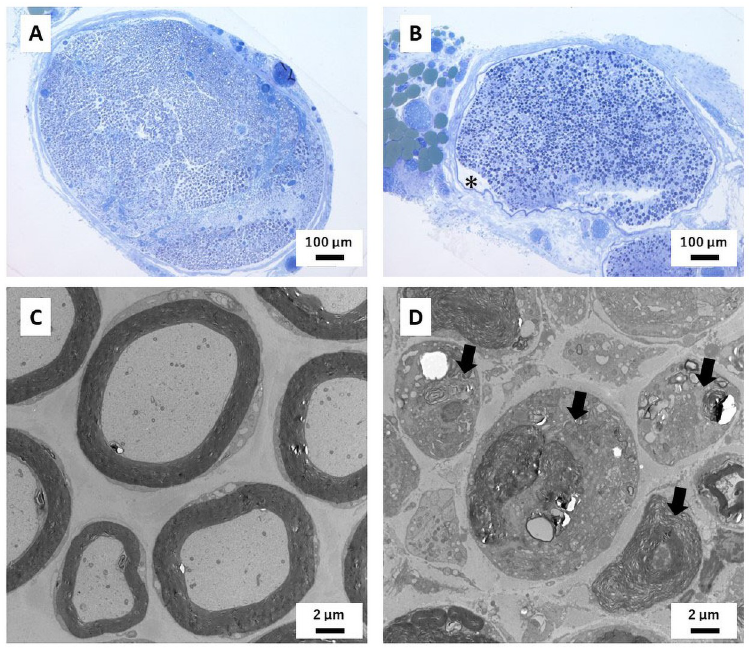
Fig 10. Representative images of transverse sections of the sciatic nerve. (A, B) Semithin sections of non-injured (A) and injured (B) sciatic nerve. Following injury, spaces between the perineurium and the nerve fascicle were enlarged (asterisk). (C, D) Ultrathin sections of non-injured (C) and injured (D) sciatic nerves. The axons distal to injured site are degenerated (Arrow).